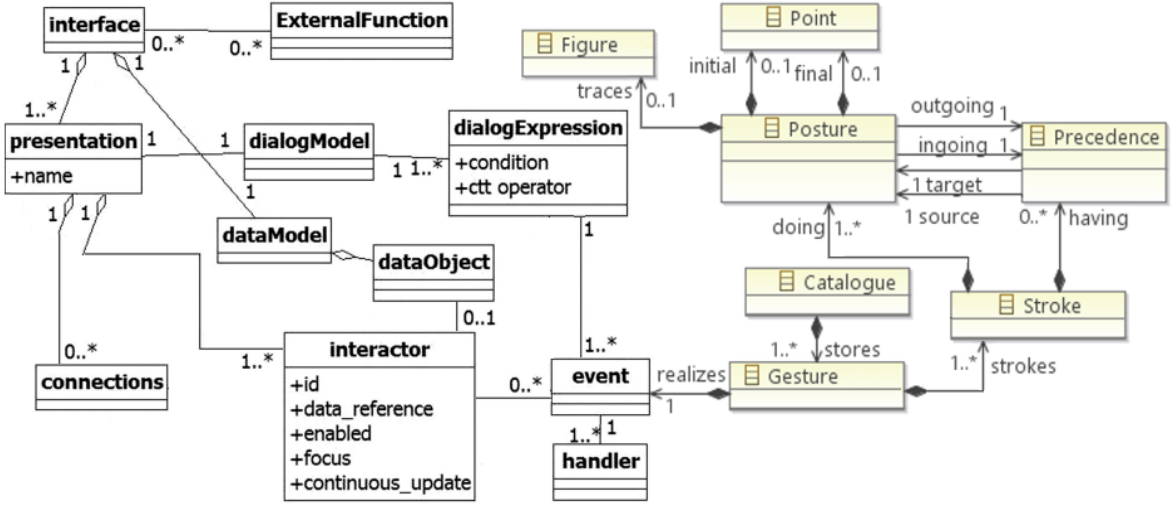
Figure A1.2. Including gesture catalogue metamodel in MARIA AUI